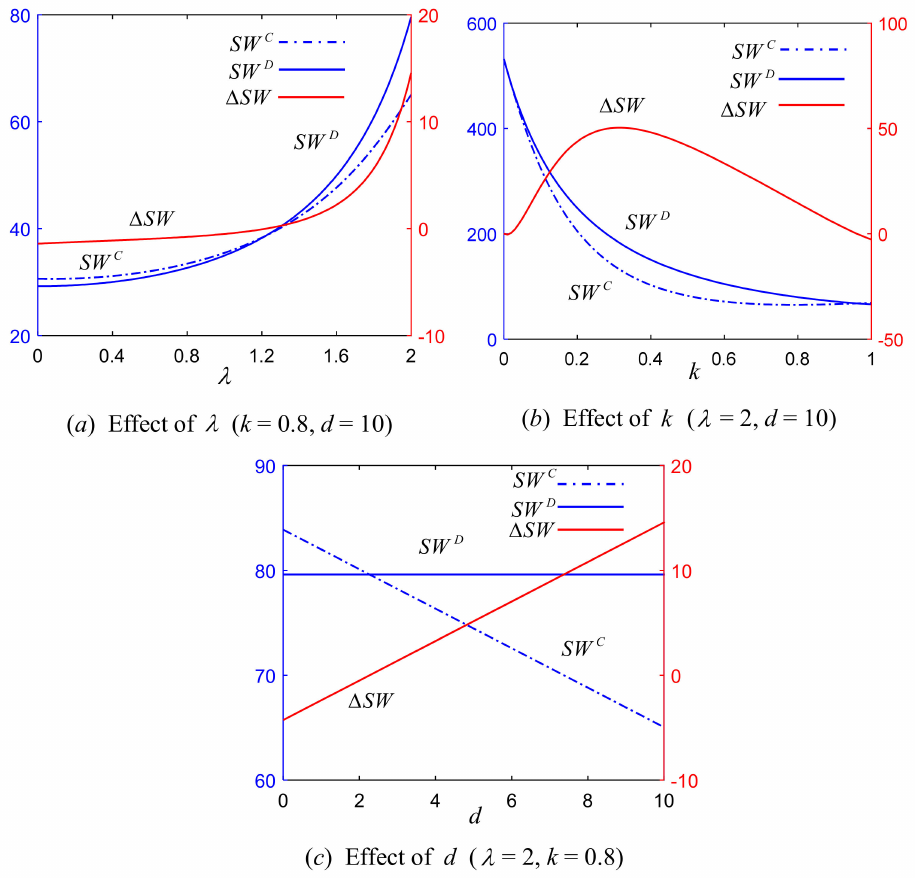
Figure 4. The effect of λ , k and d on social welfare’s